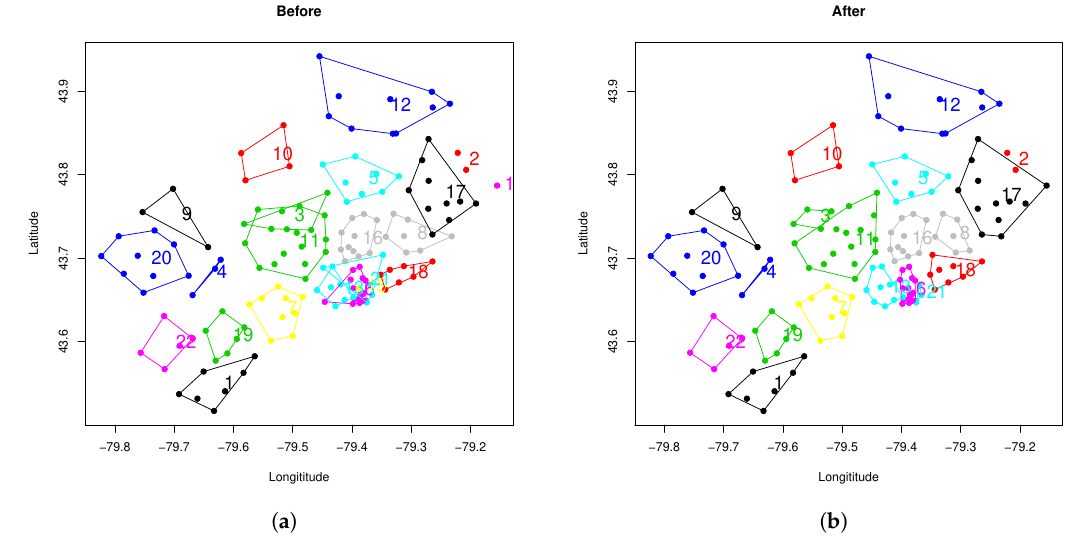
Figure 7. Convex hull plot of clusters obtained from the K -means clustering with and without the re-allocation of some isolated points. ( a ) Before contiguity constraint; ( b ) After contiguity